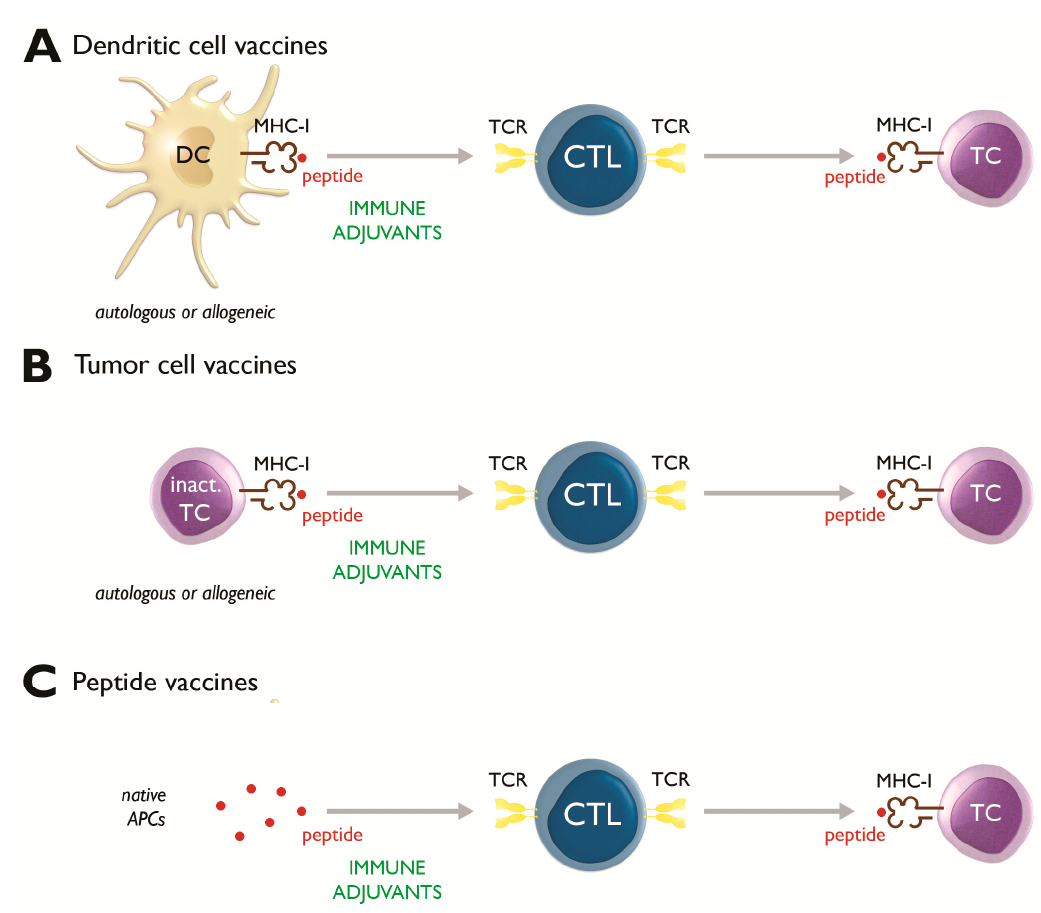
Figure 1. Mechanistic principles of anti-cancer vaccination. The most important types of tumor vaccines are dendritic cell (DC), tumor cell (TC), and peptide vaccines. The common are dendritic cell (DC), tumor cell (TC), and peptide vaccines. The common mechanism of action for mechanism of action for all tumor vaccines is the induction of tumor antigen-specific cytotoxic T- all tumor vaccines is the induction of tumor antigen-specific cytotoxic T-lymphocytes (CTLs). These lymphocytes (CTLs). These CTLs are capable of recognizing and killing TCs that express tumor CTLs are capable of recognizing and killing TCs that express tumor antigen fragments, antigen fragments, designated peptides, on their cell surface in the context of major histocompatibility complex (MHC) molecules. The recognition of the peptide/MHC is conferred by